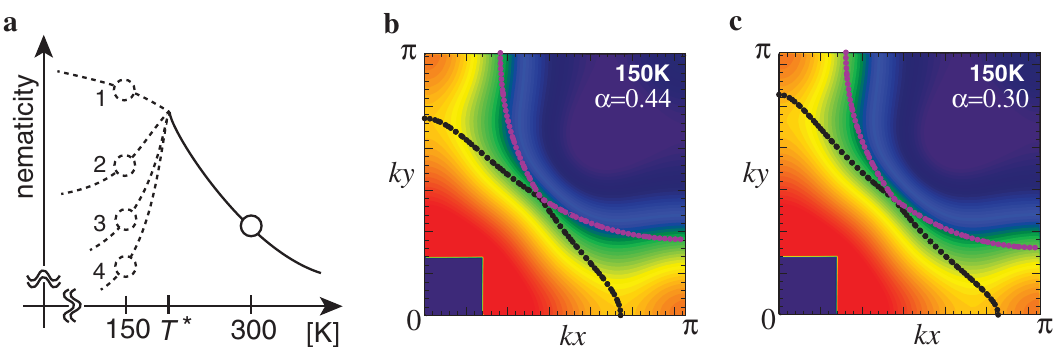
Fig. 6 Possible temperature dependence of nematicity. a Sketch of temperature dependence of the nematicity. The pseudogap temperature T * is estimated around 200 K (ref. 25 ). Given that the system is close to a nematic instability, the nematicity is expected to increase with decreasing temperature at least down to T * . It is not clear how the nematicity develops below T * and thus four possible scenarios are shown: the nematicity increases (scenario 1) or decreases (scenarios 2 – 4). In the latter case, compared with the nematicity at 300 K, the nematicity at 150K becomes larger (scenario 2), comparable (scenario 3), or smaller (scenario 4). b and c are typical Fermi surfaces for scenarios 1 and 2, and scenario 4, respectively; they are superposed on the observed map of n ( k ) at 150K. The value of α is a parameter of the nematicity and the conventional Fermi surface (ref. 9 ) is reproduced for α = 0. See Supplementary Fig. 8 for a comparison with the gradient of n ( k